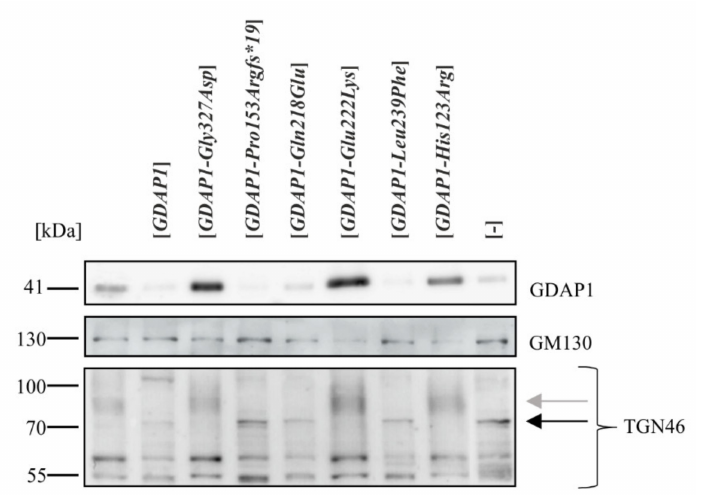
Figure 4. The level of GDAP1 protein correlates with changes in the pattern of TGN46 modifications. Western blot analysis of total cell extracts from not transfected HeLa cells (far left lane), transfected with empty vector ([-]) or vectors bearing variants of GDAP1 (as indicated). Western blots performed using antibodies against GDAP1 or against the Golgi proteins GM130 and TGN46. The black arrow indicates immature TGN46, the grey arrow shows mature, modified